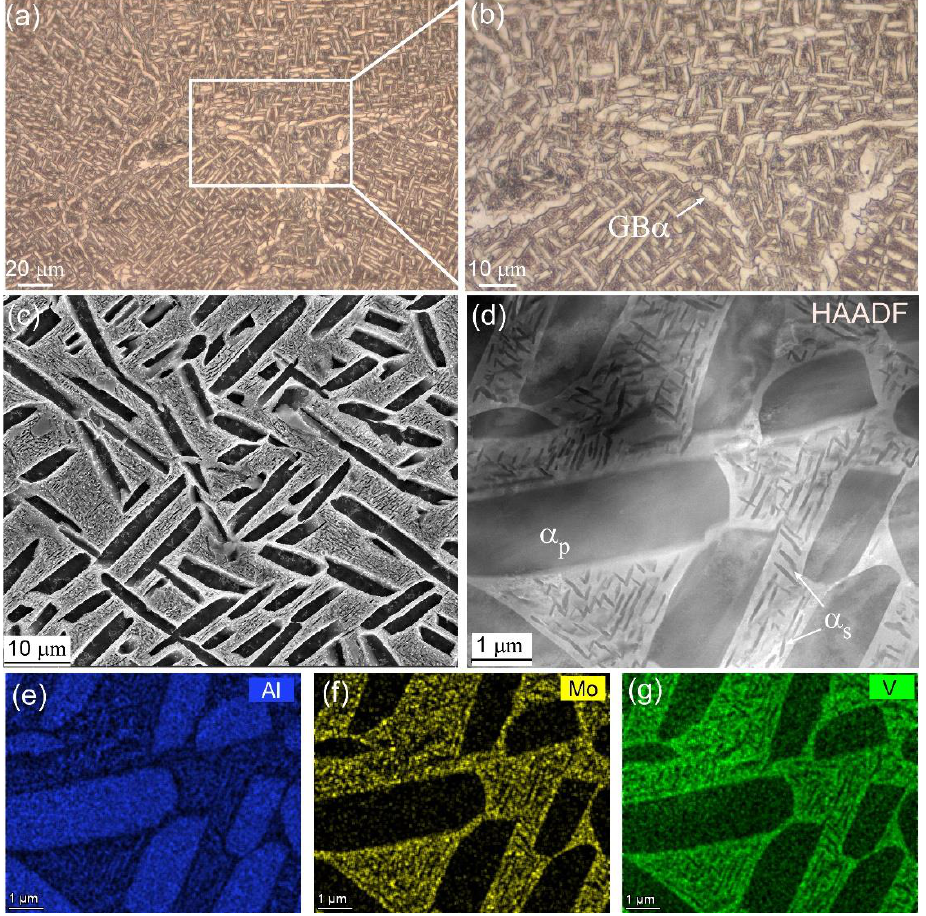
Figure 4. ( a , b ) OM images of the basket-weave microstructure, ( c ) SEM secondary electron image of the Ti55511 alloy with a basket-weave microstructure, ( d ) TEM-HADDF image showing the morphologies of the α p phase and the β trans structure, and ( e – g ) the STEM-EDS results collected in (d).